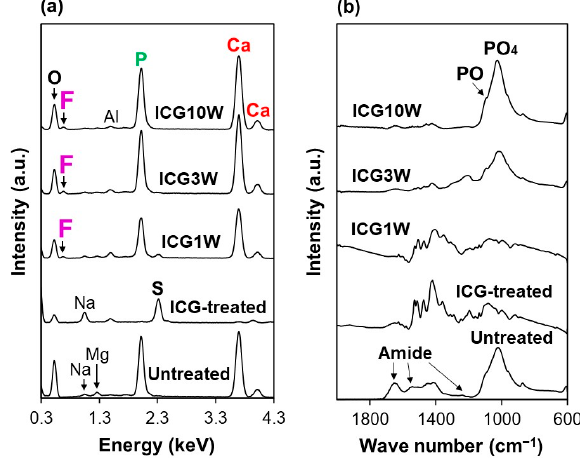
Figure 3. ( a ) SEM-EDX and ( b ) FT-IR spectra of the surfaces of the untreated substrate, ICG-treated substrate, and LAB-processed substrates: ICG1W, ICG3W, and ICG10W. The small Al peak in ( a ) is derived from the sample holder.